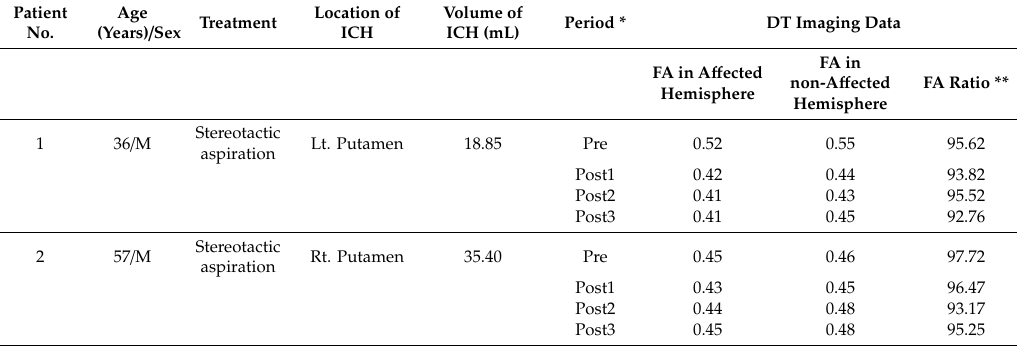
Table 1. Patient characteristics and di ff usion tensor tractography fractional anisotropy values of the good outcome